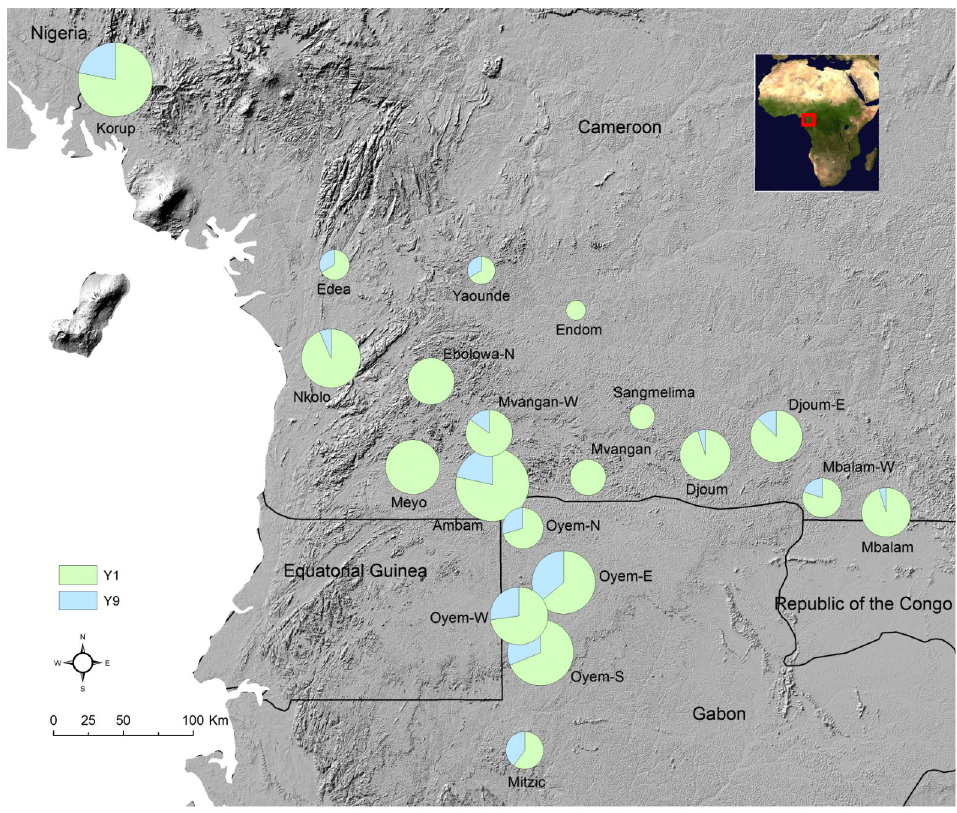
Figure 3. Spatial distribution of Chaetothyriales MOTUs of the Tetraponeraaethiops/Barteriafistulosa system. Sectors represent the proportion of each Molecular Operational Taxonomic Unit in each sampling site. MOTUs were detected using universal and/or specific ITS primers. When specific ITS primers were used, PCR products were not always sequenced. Size of pie charts is proportional to sample size (i.e., the number of fungal samples for which at least one Chaetothyriales MOTU was detected).